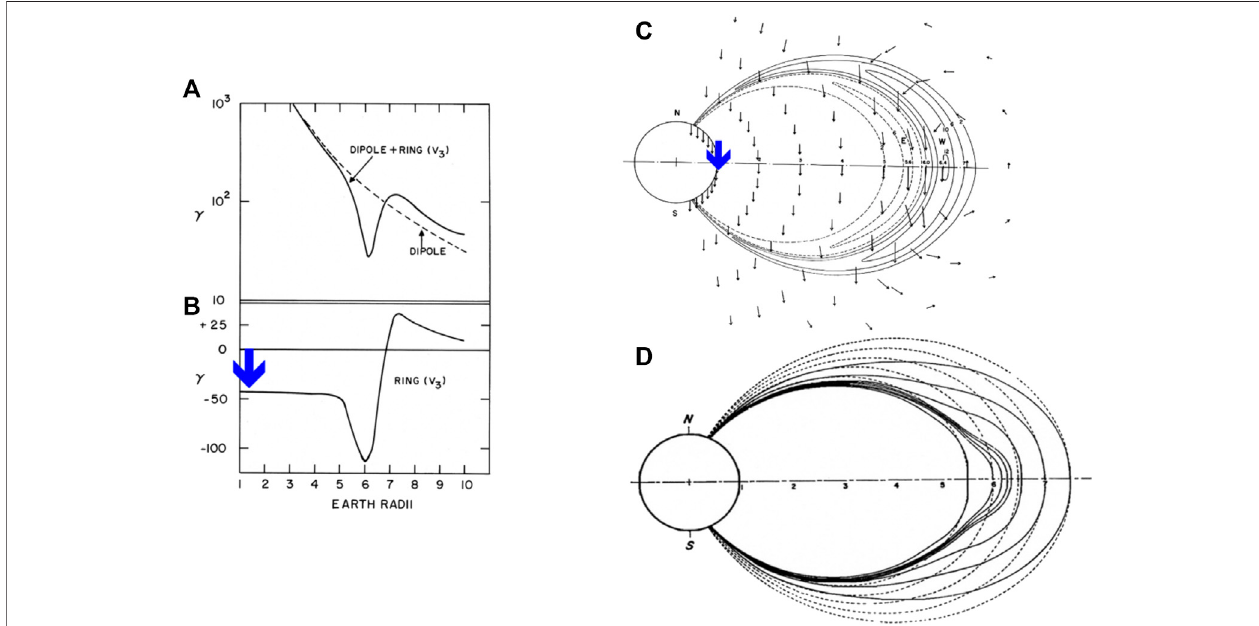
FIGURE 7 | (A) The changes of the Earth ’ s dipole fi eld produced by a model ring current. (B) The magnetic fi eld produced by the ring current on the equatorial plane. The blue arrow indicates the main phase decrease. (C) The distribution of the current in the ring current and the magnetic fi eld produced by the ring current. (D) The distortion of the Earth ’ s dipole fi eld by the ring